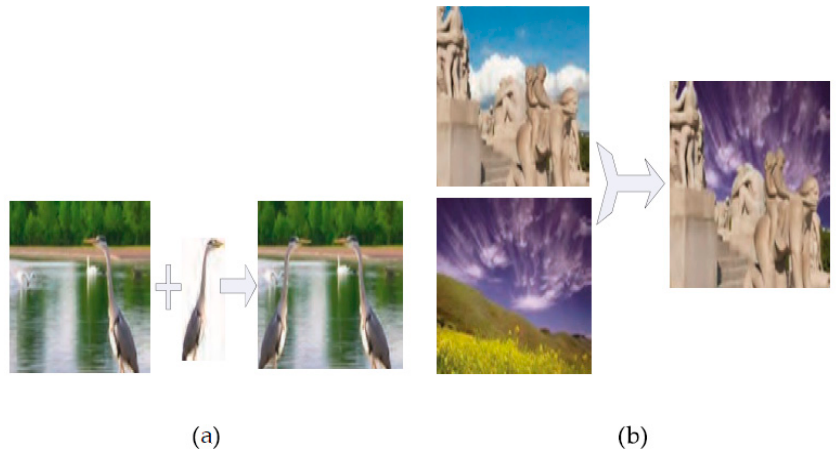
Figure 8. ( a ) Tampered image in CASIA_v2 dataset ( b ) Tampered image in CASIA_v2 dataset.